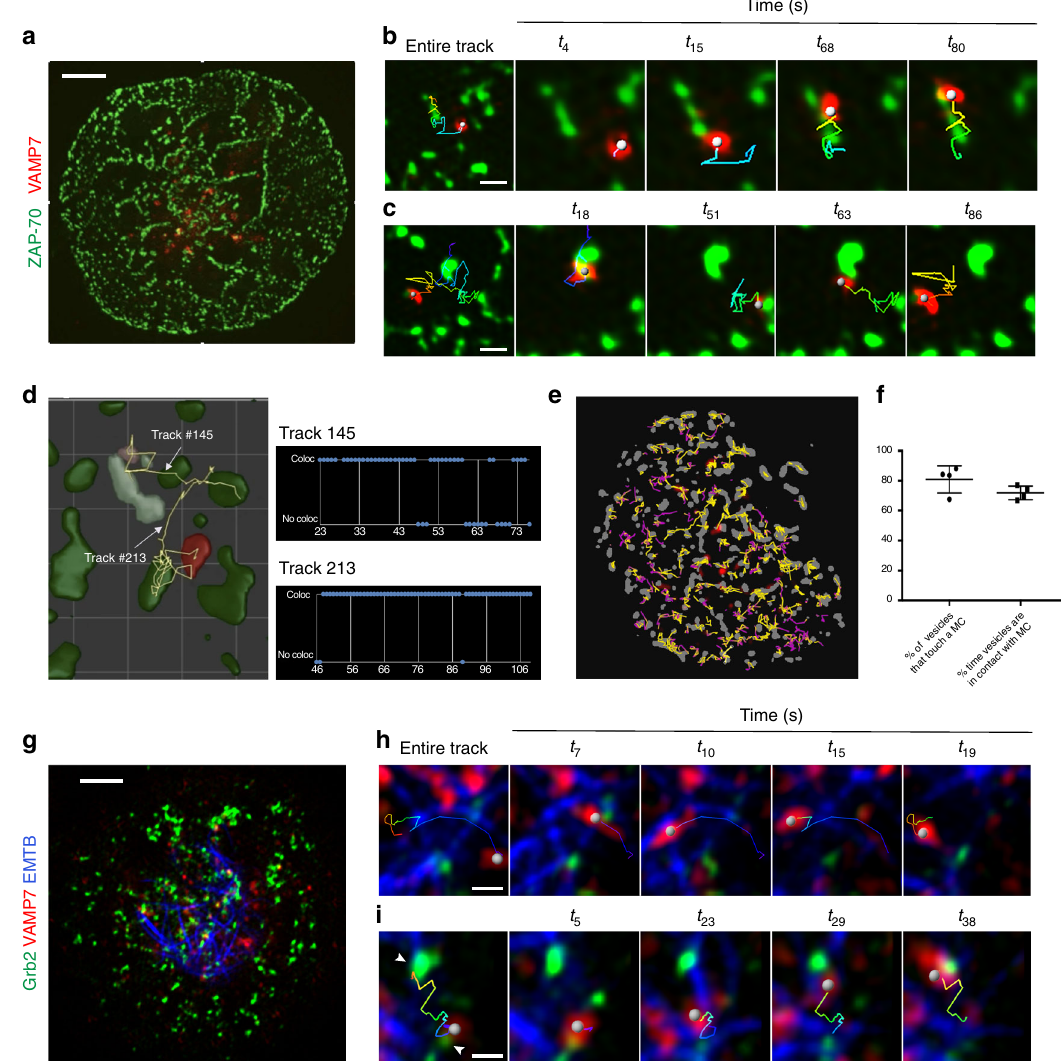
Fig. 5 VAMP7 vesicles track between microclusters on microtubules at later times after activation. Jurkat cells transfected with indicated constructs were dropped onto stimulatory coverslips and imaged by TIRF-SIM 5 min after initial stimulation. a – e Jurkat cells were transfected with ZAP-70-apple and emerald-VAMP7. a Image of the entire cell. Scale bar equals 2 μ m. b , c Zoomed-in images focusing on a single VAMP7 vesicle and a few ZAP-70 microclusters. b shows a vesicle tracking on a microcluster; c shows a vesicle tracking between multiple microclusters ( n = 7 cells, three independent experiments). Scale bars for b and c equal 0.2 μ m. d Zoomed-in area of a region of interest of a cell in which vesicles (red) and microclusters (green) have been segmented and show two tracks of VAMP7 vesicles moving between ZAP70 clusters. To the right are time plots of the tracks shown in d indicating when colocalization (coloc) or no colocalization (no coloc) between VAMP7 and ZAP-70 was observed. e Spatiotemporal map of an entire cell with ZAP- 70 microclusters in gray and VAMP7 tracks in yellow (when they colocalized with ZAP-70) or purple (when no colocalization was observed). f Graph of the percentage of vesicles per cell associated with microclusters and the frames that a vesicle was associated with a microcluster in the lifetime of its appearance in the TIRF fi eld. g Jurkat cells were transfected with EMTB-GFP, Grb2-apple, and Halo-VAMP7. Image of the entire cell. Scale bar equals 2 μ m. h , i Zoomed-in image focusing on a single tracked VAMP7 vesicle. h shows a vesicle tracking on a microtubule; i shows a vesicle tracking on a microtubule between two Grb2 microclusters indicated by indented arrowheads ( n = 5 cells, three independent experiments). Scale bars for h and i equal 0.2 μ m. In b , c , h , and i , the tracked vesicle is indicated as a gray sphere. The entire track is shown and color-coded to indicate time (earliest time point in blue and the latest time point in red). In the fi rst panel, the entire track is shown. The remaining panels show four time points, each with a track that displays the previous fi ve time points in b and c or previous 20 time points in h and